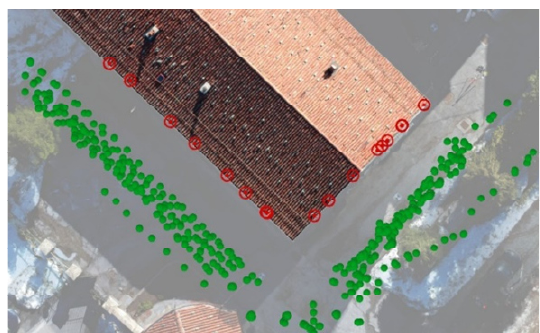
Figure 11. Positions of the camera for the images captured with the DJI Spark (green) and the markers placed on the façade (red).